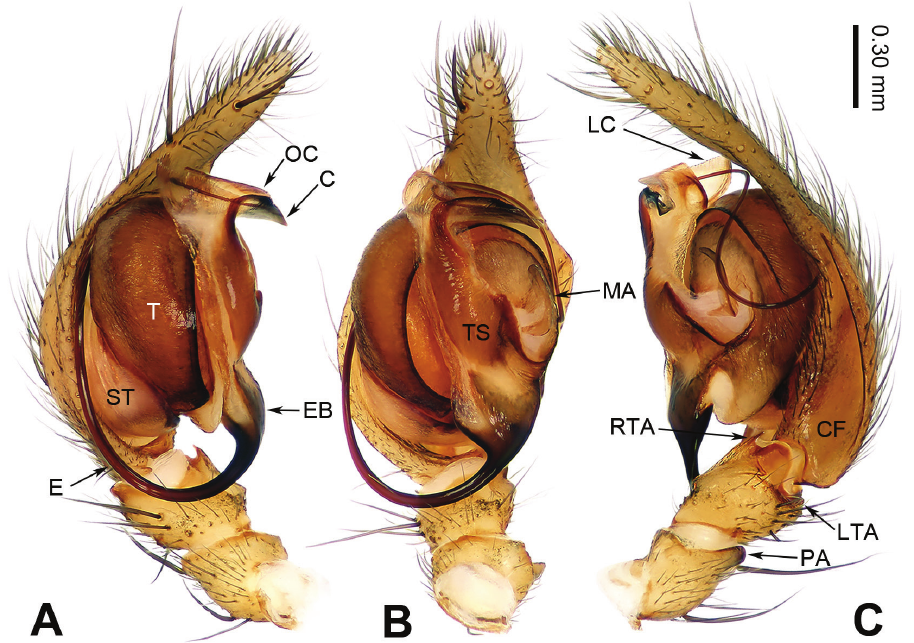
Figure 5. Left male palp of Guilotes xingpingensis sp. n., holotype. A Prolateral view B Ventral view C Retrolateral